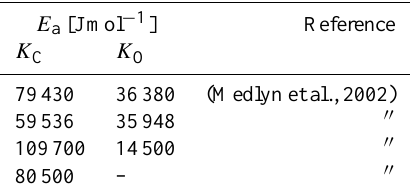
Table B2. Overview of the enzyme activation energies E a of the Michaelis–Menten constants K C and K O